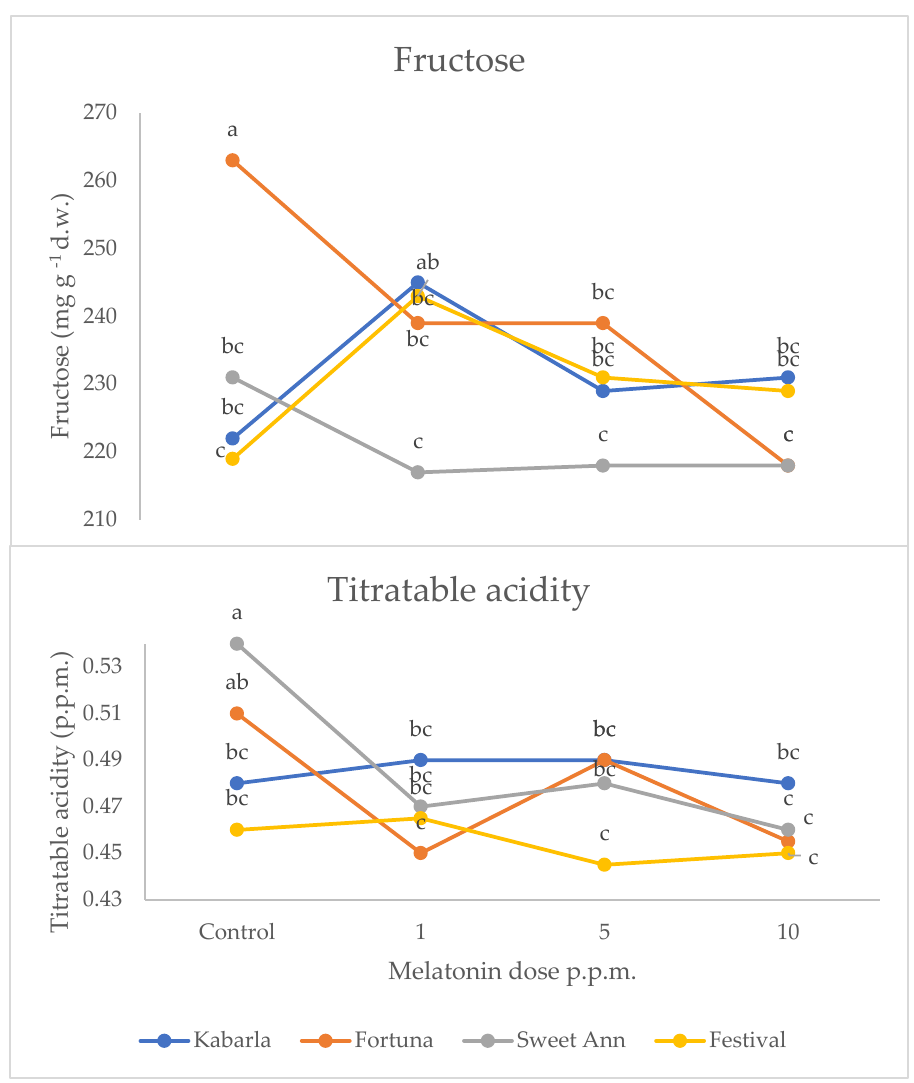
Figure 3. Interaction between Cultivar and Melatonin dose on fructose content and titratable acidity of strawberry fruits grown in Isparta region (Turkey), the values followed by different letters are statistically different according to Tukey’s HSD test at p ≤ 0.05.